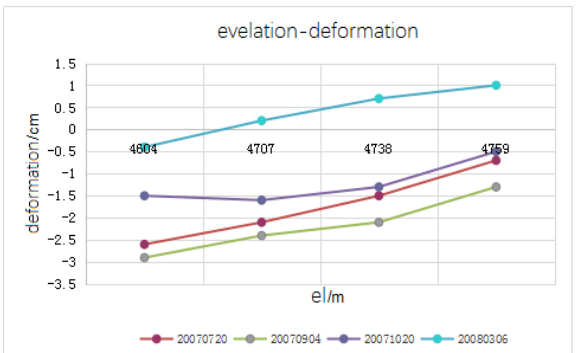
Figure 7. Elevation-Deformation Chart for test points 6-9 in the mountainous region